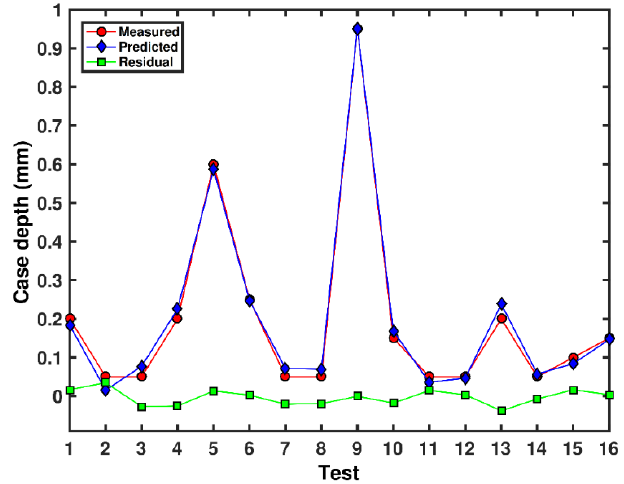
Figure 6. Measured values of case depths [µm] at the tip of the splines ’ tooth versus the predicted values.